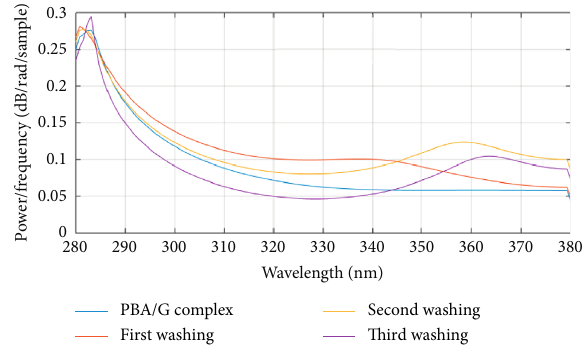
Figure 3: UV-vis absorption spectra of centrifuged supernatant